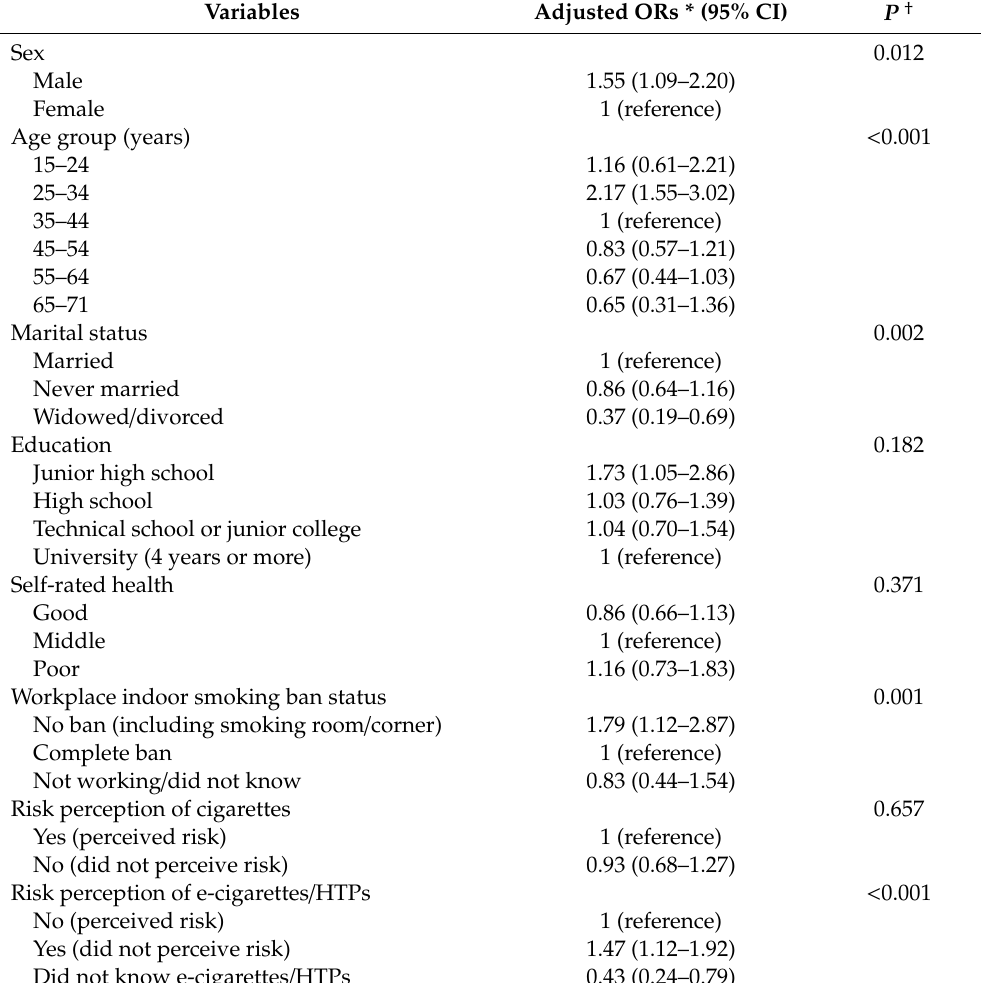
Table 3. Predictors of multiple tobacco products use among current product users in